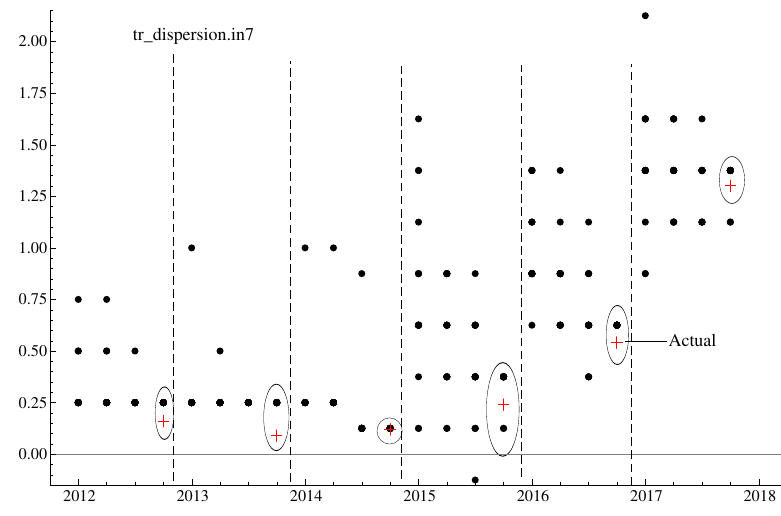
Figure 1. Appropriate Federal Funds Rates for the Current